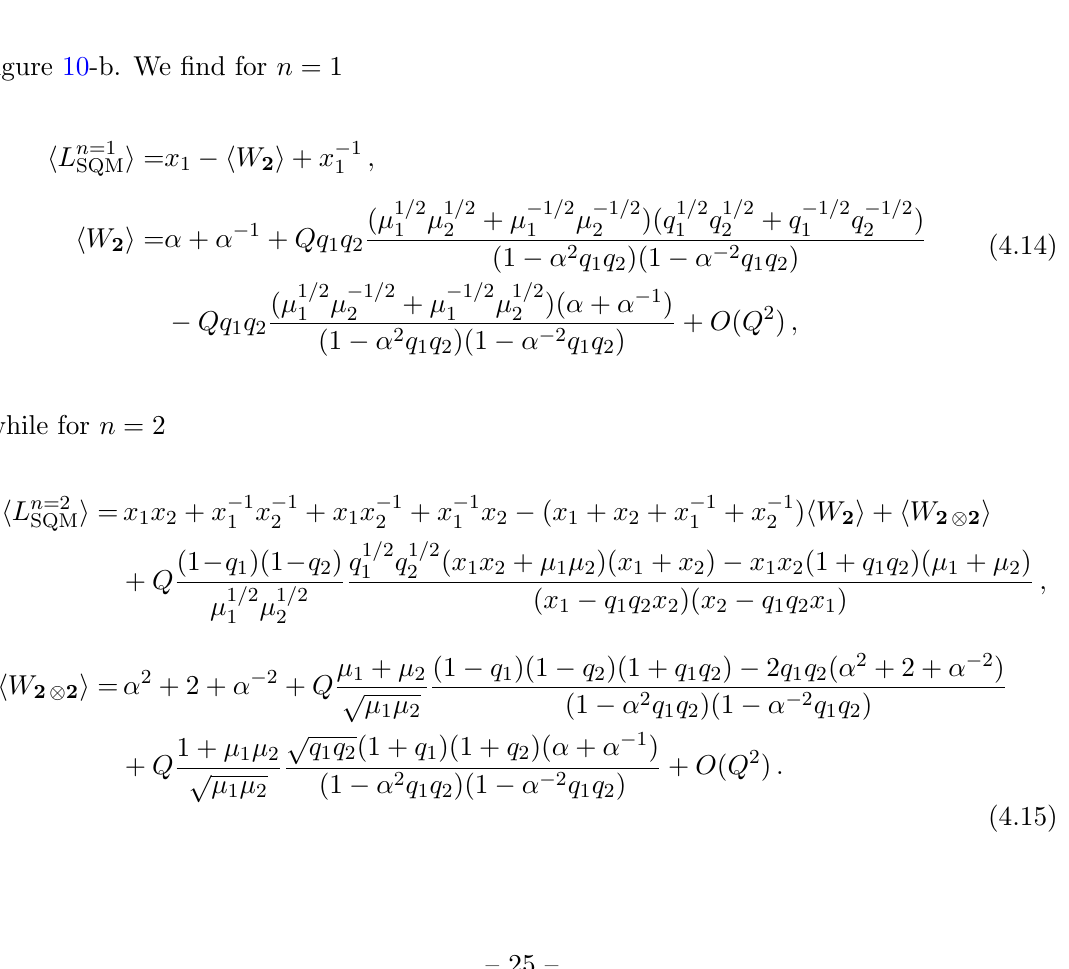
(cid:12)gure 10-b. We (cid:12)nd for n =